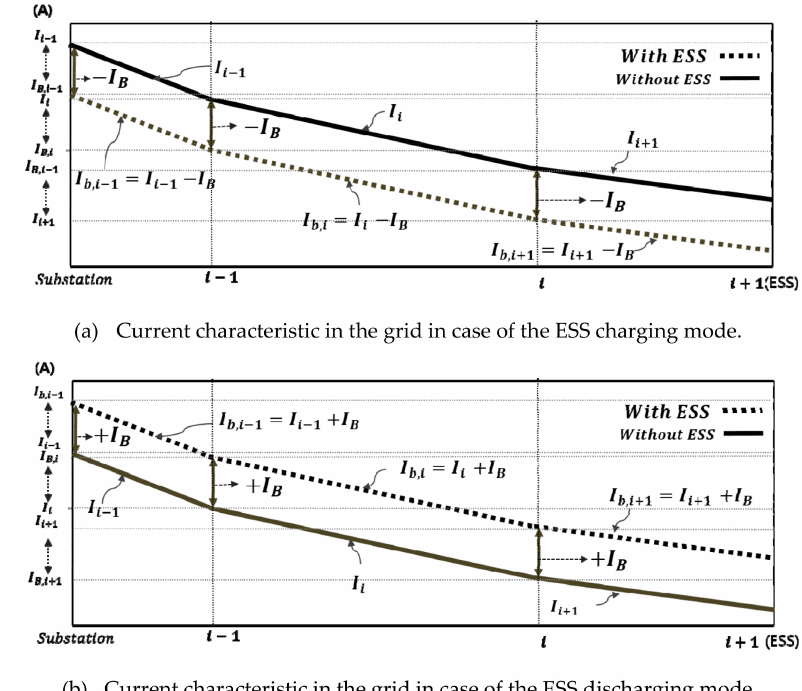
Figure 12. Current characteristic in the grid according to the ESS